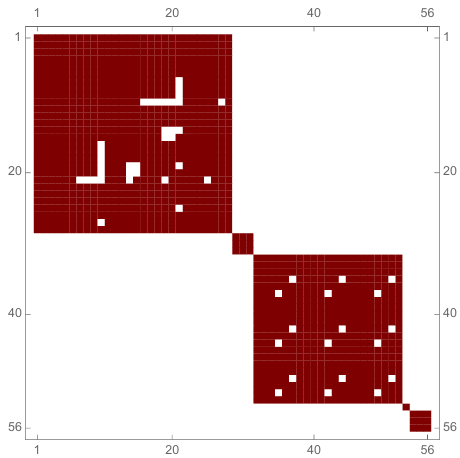
Figure 1 . Structure of the P-matrix for four gravitons, output of Mathematica command ‘Ma- trixPlot’. White indicates zero, burgundy non-zero entries. An explanation for the \game of life" pattern of zeroes within the blocks would be